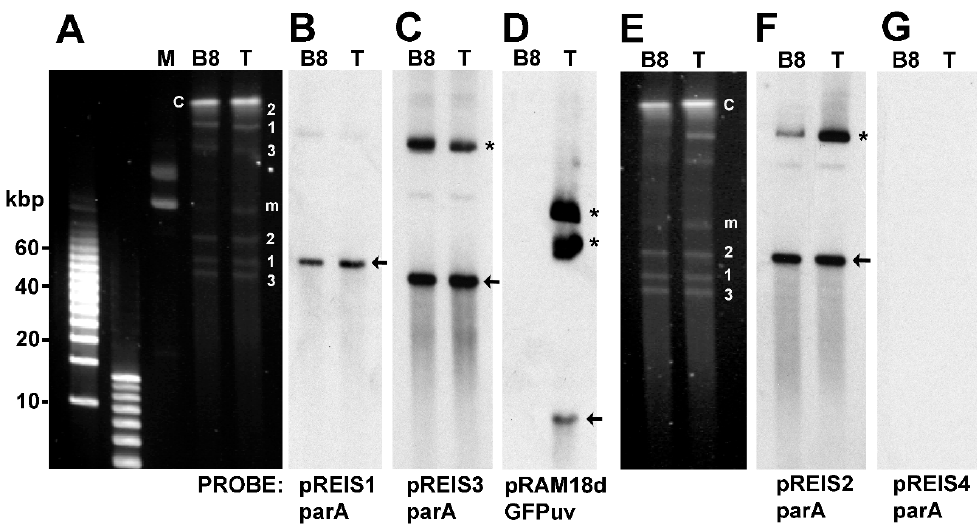
Figure 3. Identification of shuttle vector pRAM18dRGA and native plasmids pREIS1-3 in R. buchneri transformant and clone B8 by pulsed field gel electrophoresis (PFGE) and Southern blot (SB) analysis. Native R. buchneri (B8) and pRAM18dRGA (T) plasmids in REIS. A. PFGE gel; B & C. SB of gel in panel A probed with digoxygenin labeled parA probes specific for pREIS1 and pREIS3, respectively; D. SB of panel A probed with GFPuv; E. PFGE gel; F & G. SB of gel in panel A probed with digoxygenin labeled parA probes specific for pREIS2 and pREIS4, respectively. Asterisks mark putative linear monomer of each plasmid and arrows indicate their conformational isomers. IRE11 mitochondrial DNA—m. Chromosomal DNA—C. Linear DNA marker positions are to the left of panel